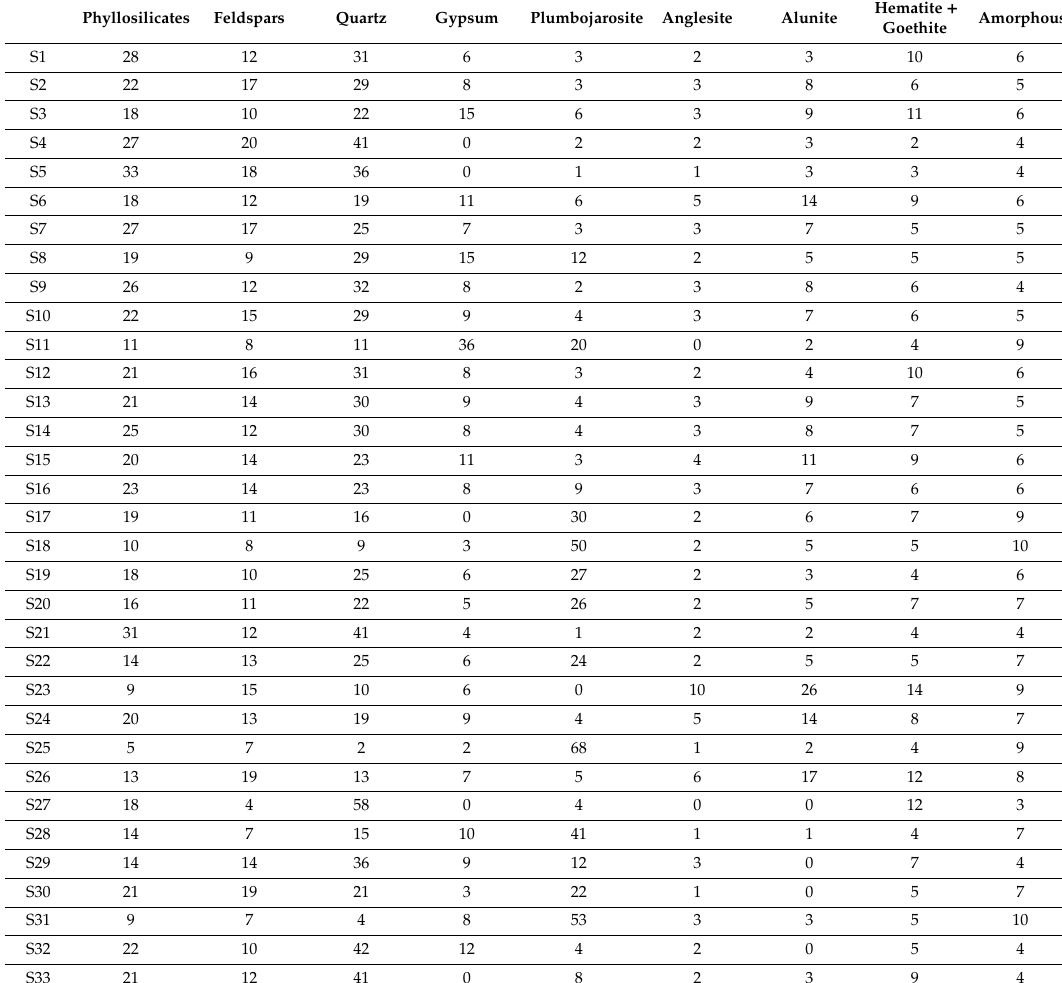
Table 3. Mineralogical composition (%) of soil